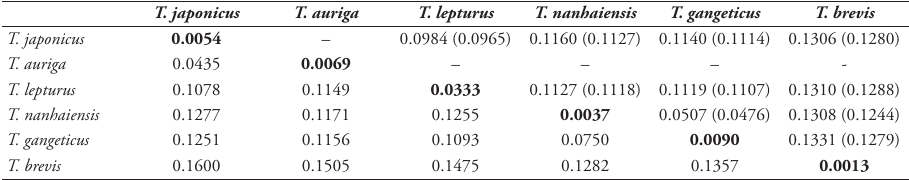
Table 2. The p-distance based on sequences of partial COI (below) and mitogenome (above, excluding d-loop in brackets). Bold indicates the mean COI divergence within groups.